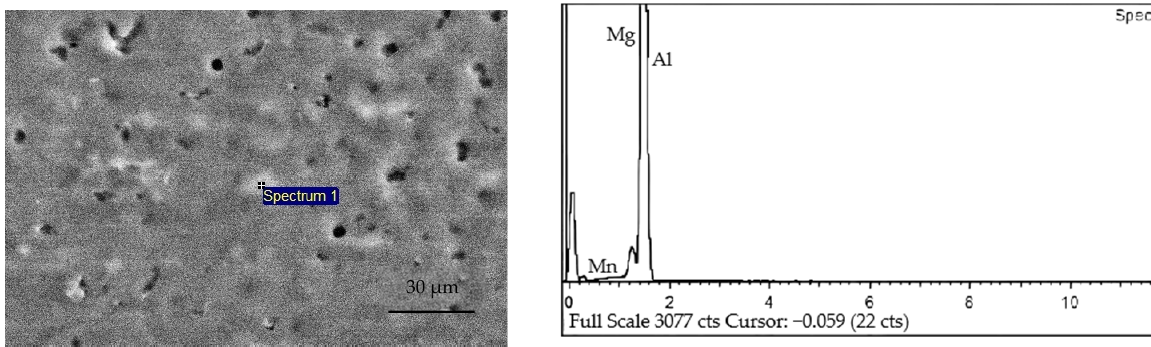
Figure 7. EDS point scanning results of Al-Mg alloyed additive.